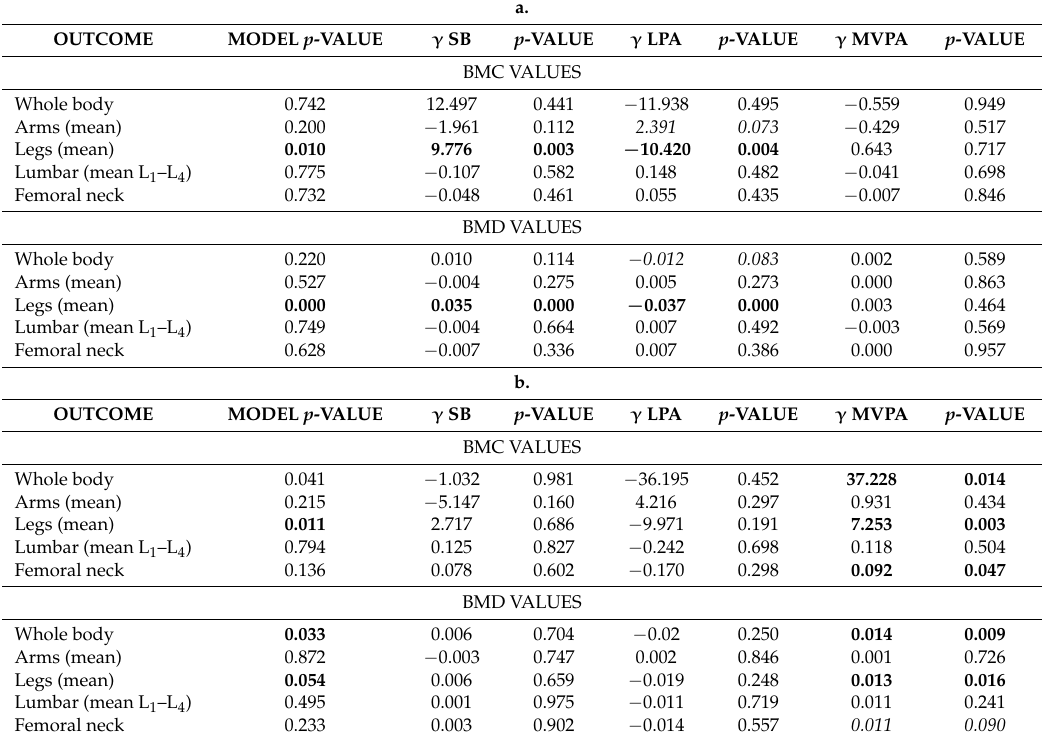
Table 2. Compositional behavior model for bone mass variables for the proportion of the waking hours of the day spent in SB, LPA and MVPA for robust older people ( a ) and pre-frail older people ( b ).